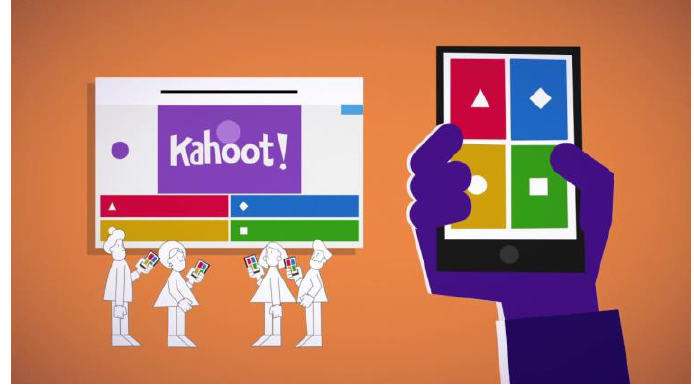
Fig. 1. Illustration of Kahoot!